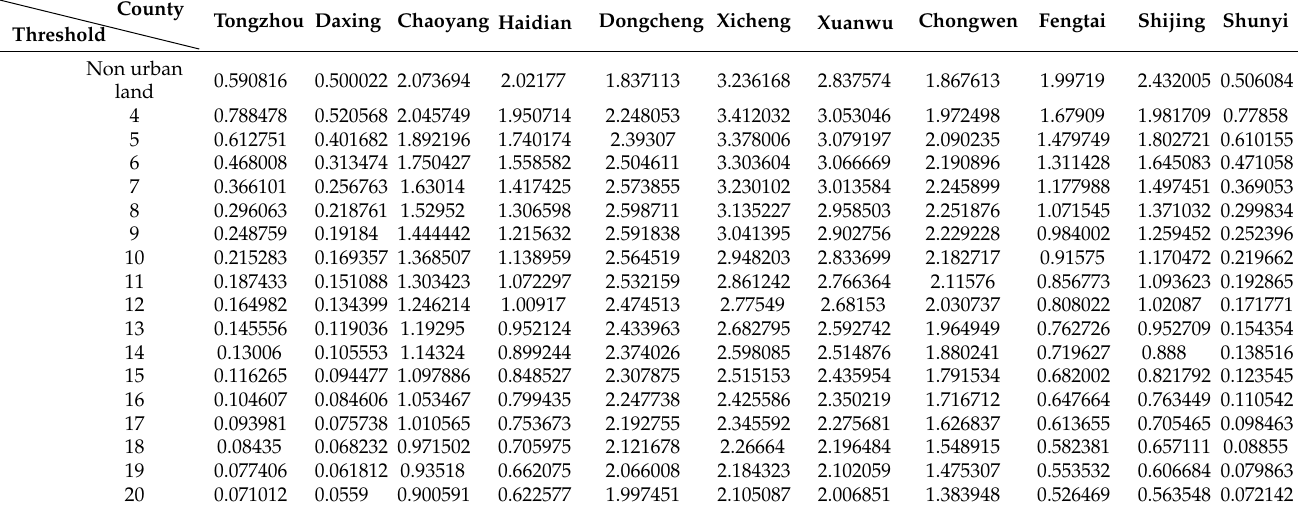
Table 4. ABHE values of each county in Beijing based on different exclusion thresholds.